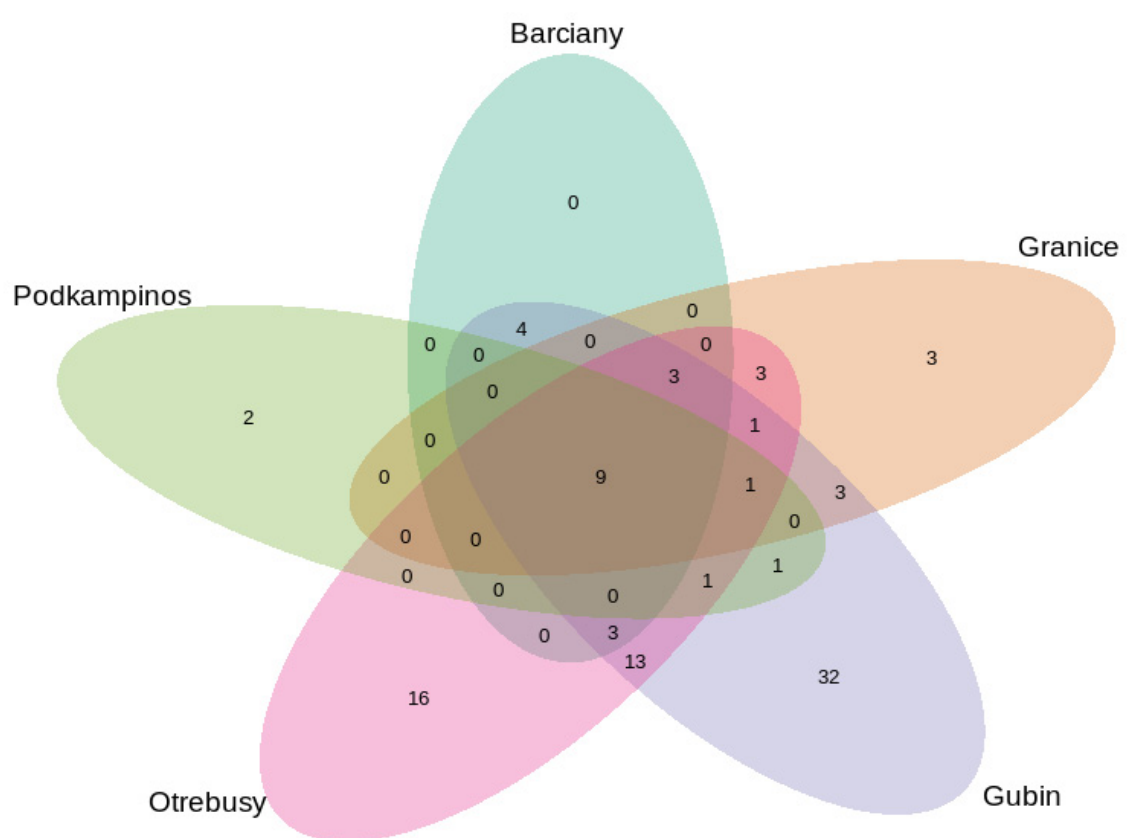
Figure 5. Venn diagram showing the numbers of shared and unique bacterial genera in leaves from from different localities .